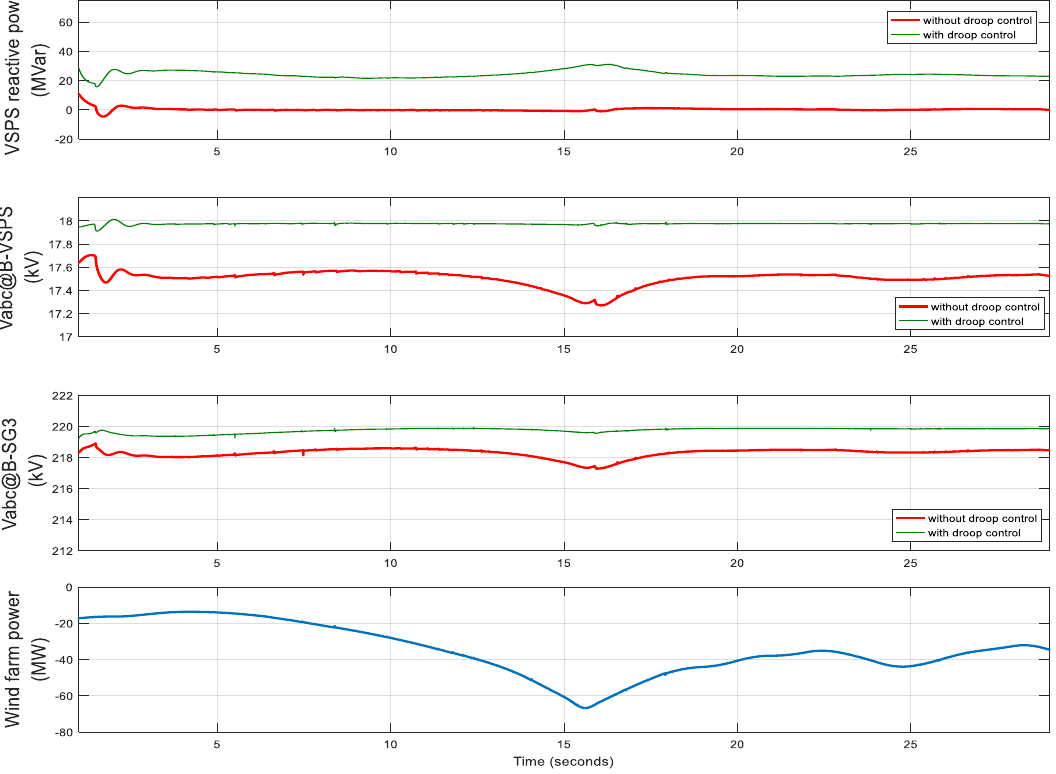
Figure 15. Evolution of the network in AC-bus voltage response of the VSPS control system considered at two buses by comparing the reactive power control with and without droop control while the wind is fluctuating.